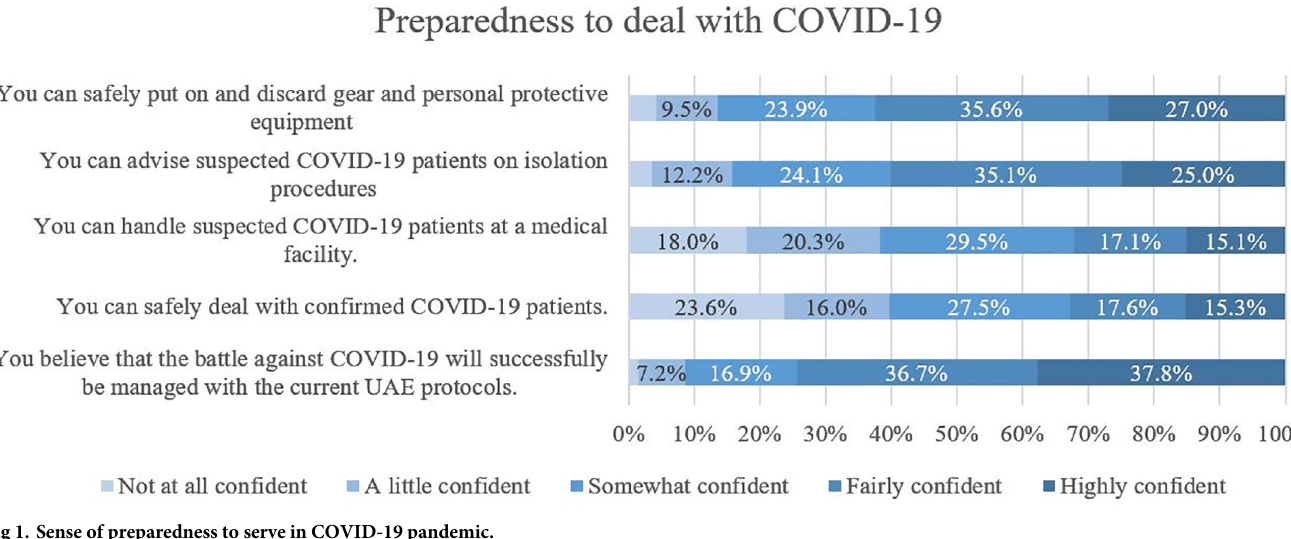
Fig 1. Sense of preparedness to serve in COVID-19 pandemic.